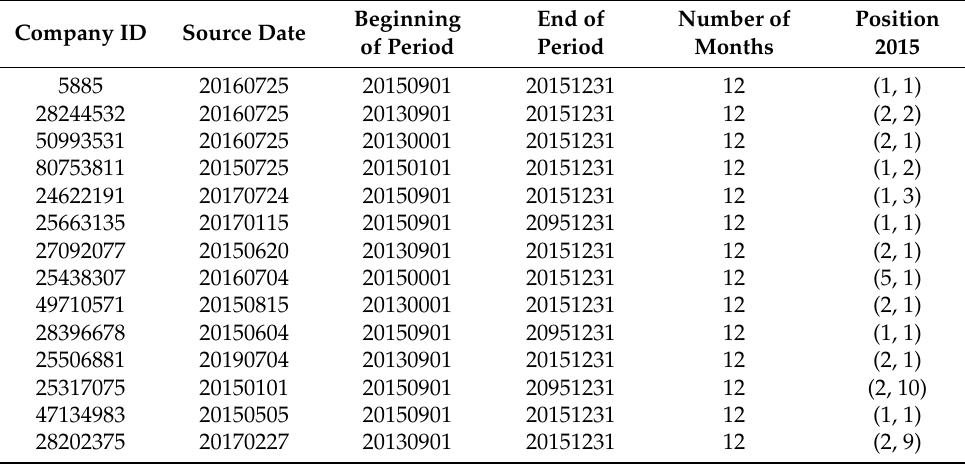
Table 1. Original data file with assigned positions.